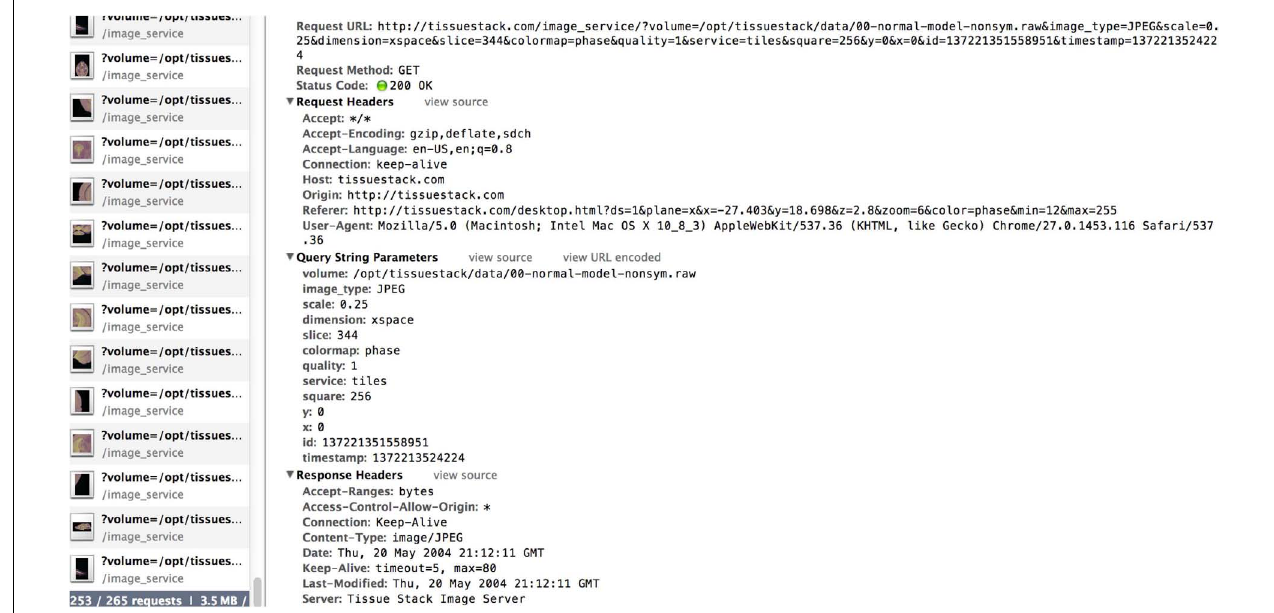
FIGURE 2 | Example of the RAW file querying request as shown by Google ChromeWebkit Inspector